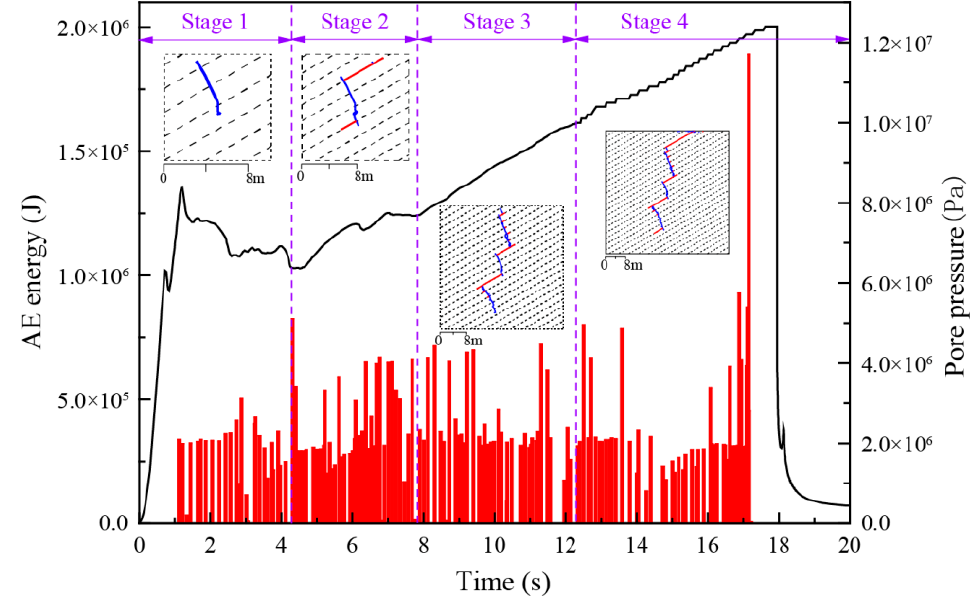
Figure 9. Pore-water pressure and AE-energy. During different stages, the fractures showed different propagation modes, and the AE energy presented with different distribution characteristics. The AE energy of bedding slip fracture was concentrated. The energy of cross-layer fracture was dispersed.